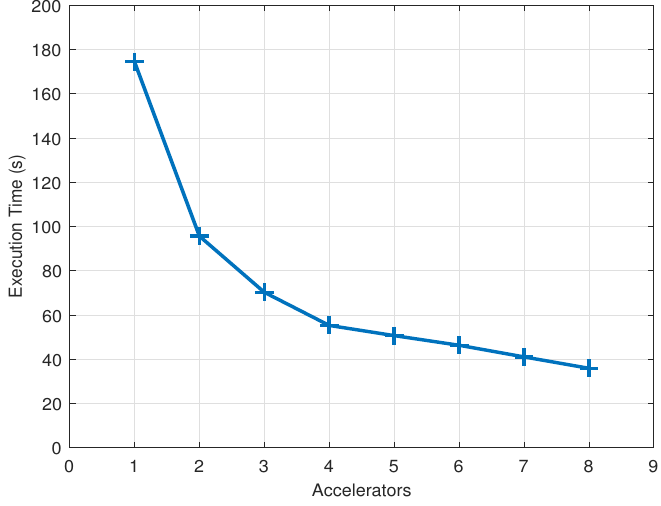
Figure 8. Performance versus number of